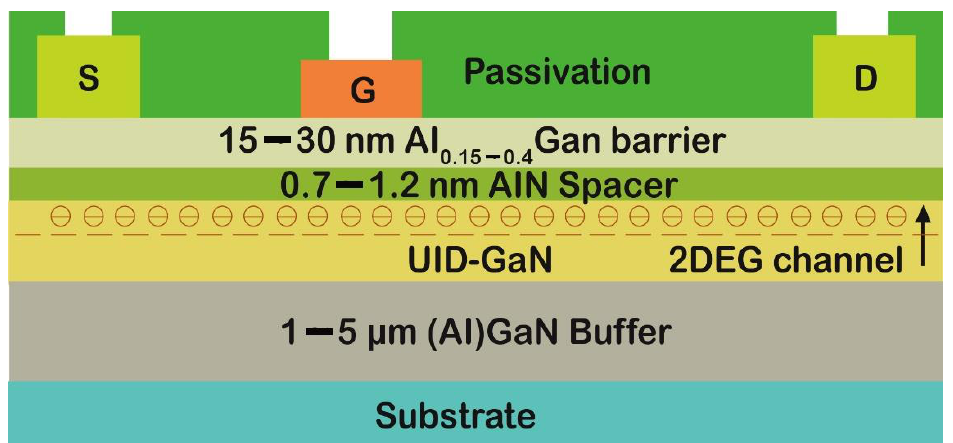
Figure 18. Device layout for a GaN HEMT structure that is normally on.